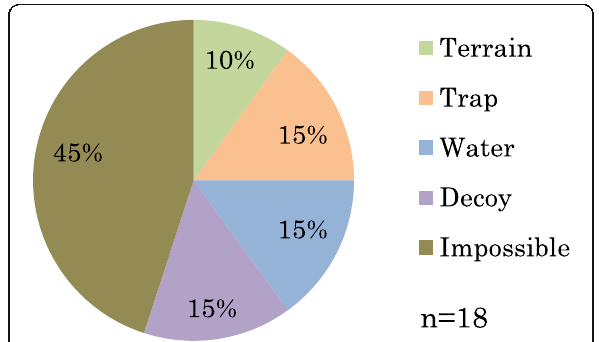
Figure 2 Idea of capturing method of African wild ass for domestication by Afar community around Danakil desert (Area